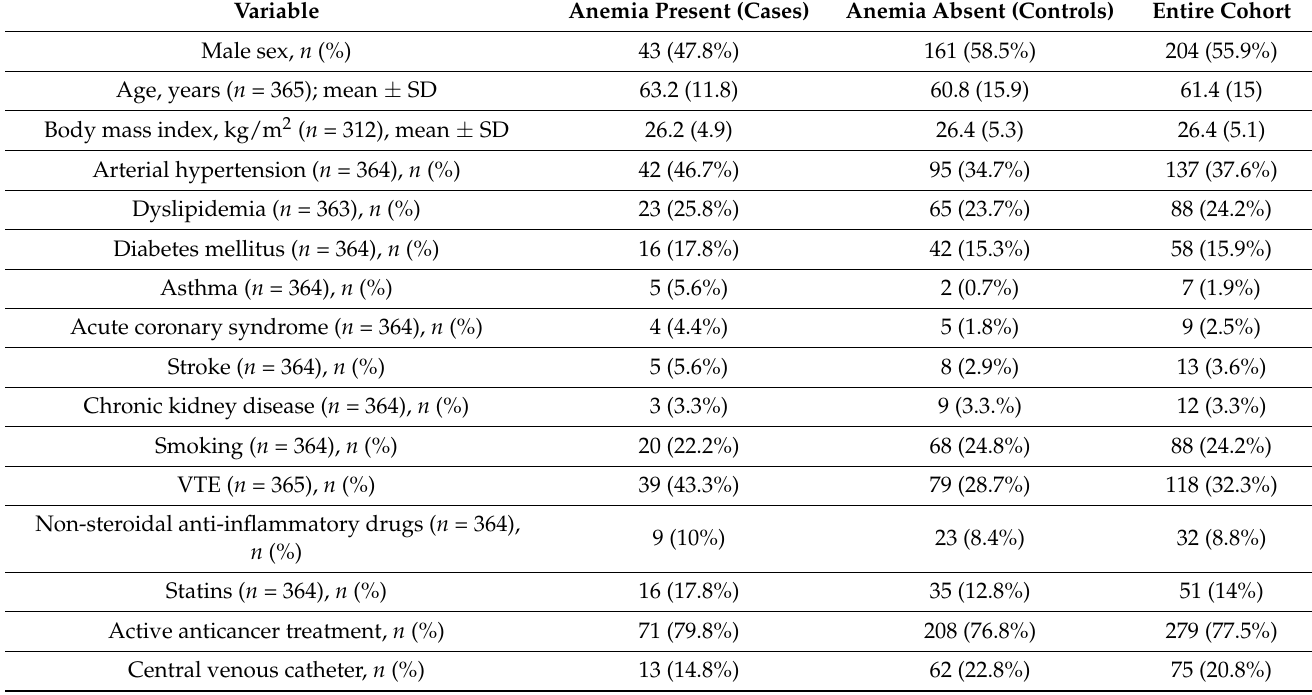
Table 1. Clinical characteristics of the study